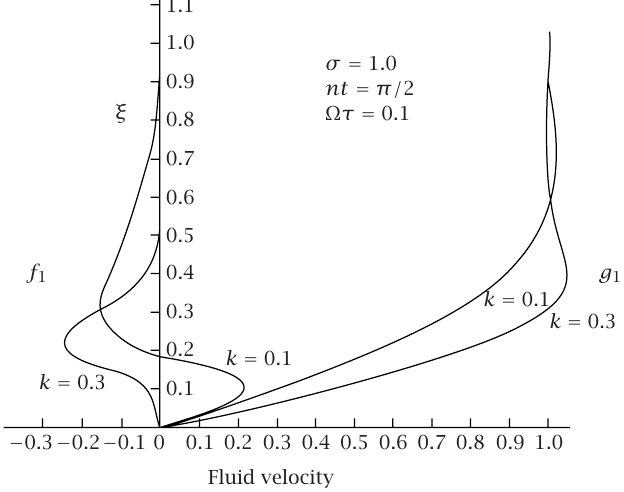
Figure 4.2 . Variations of f 1 and g 1 for different values of particle concentration k in the resonant case and for fixed values of nt and Ω τ when σ =